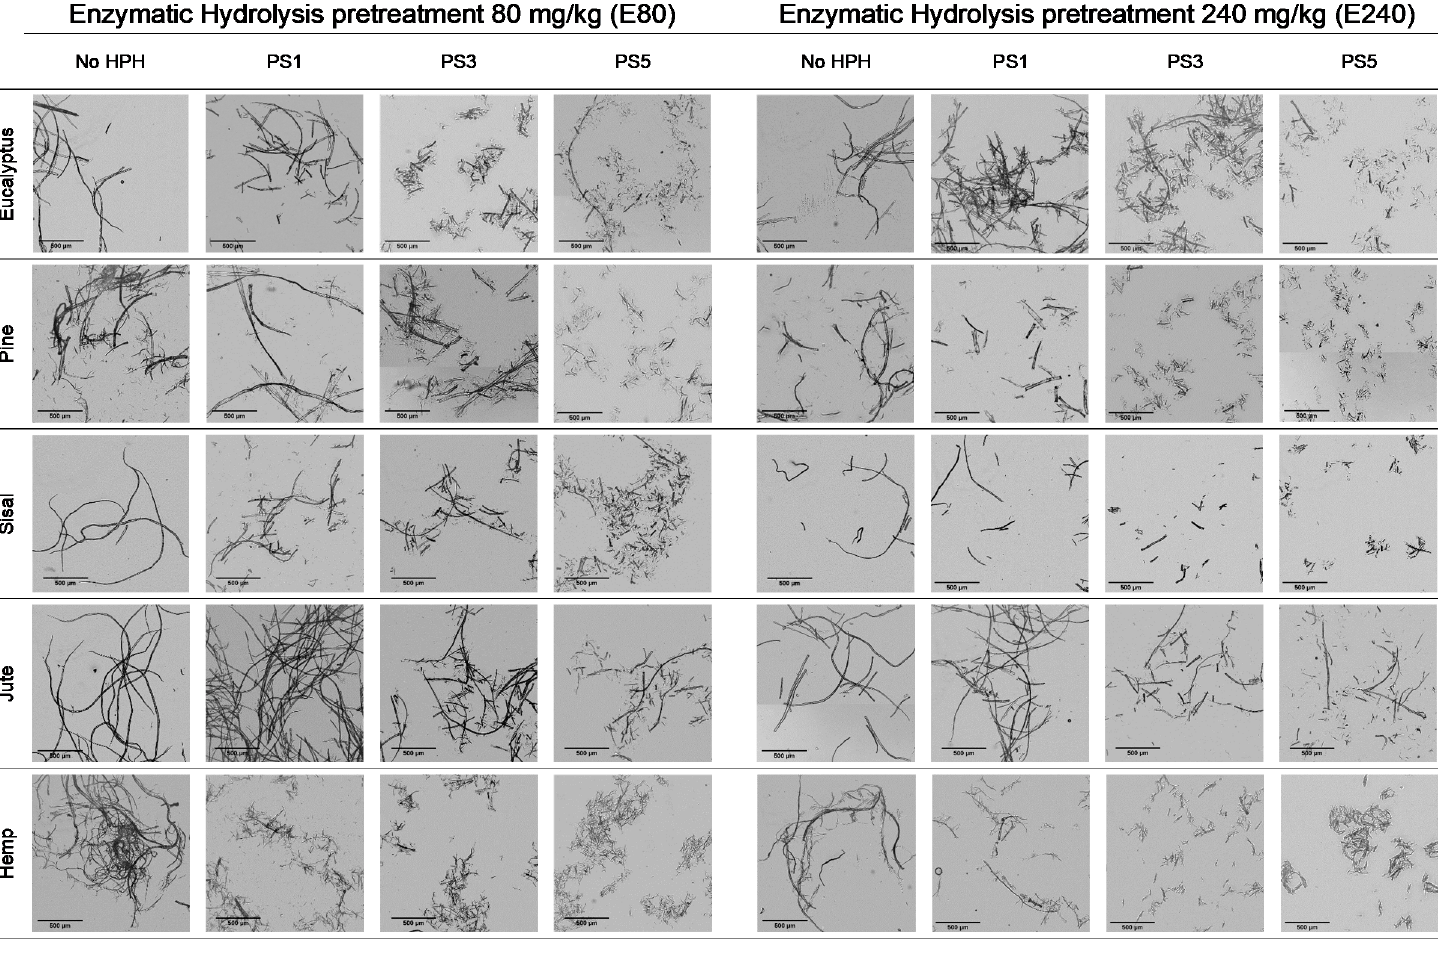
Figure 3. Optical microscopy images at 5× magnification of cellulose and CMF/CNFs with enzymatic hydrolysis pretreatment.